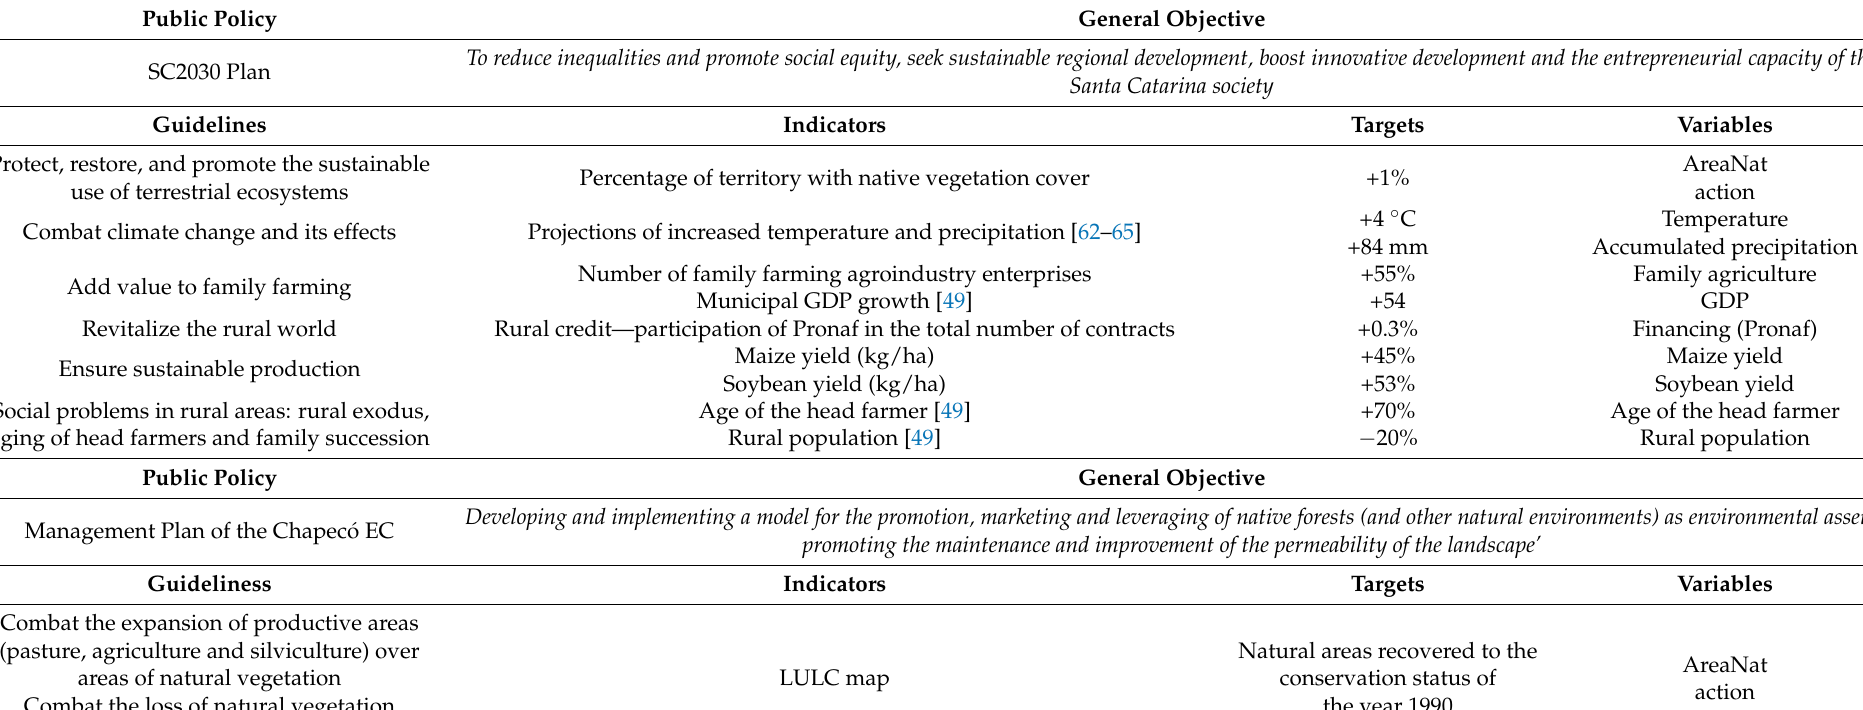
Table 5. Summary of public policy guides used to build